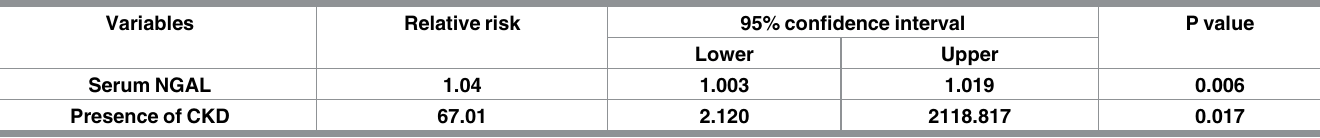
Table 4. Predictors of AKI (multivariative